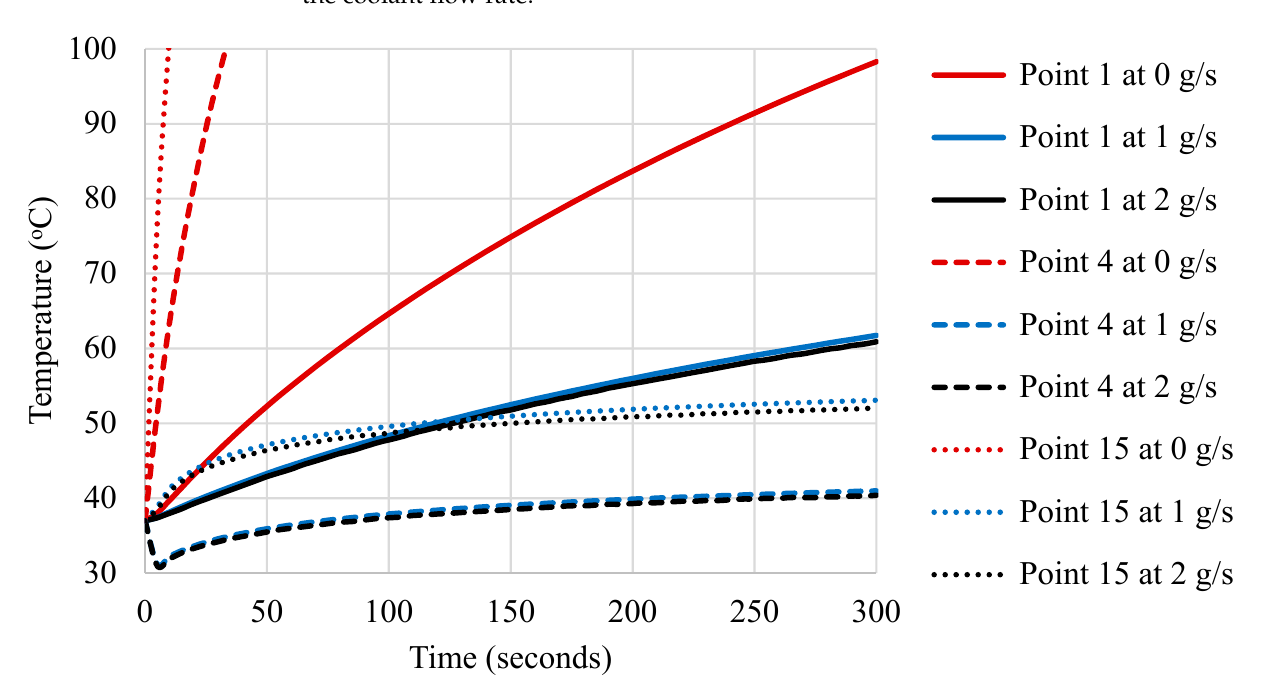
Figure 11. Temperature variation as a function of time for several locations (identified in Figure 7) on the probe surface corresponding to Cases 3, 5, and 6 (30 W input power) where the coolant flowrate was parametrically varied from 0, 1, and 2 g/s respectively.